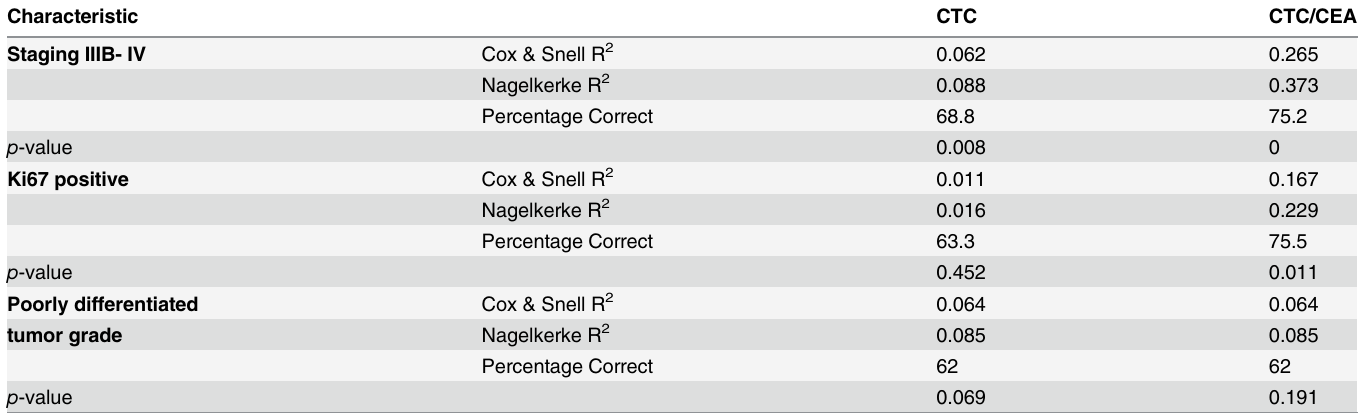
Table 6. Prediction of NSCLC aggressiveness and TNM staging with CTCs or/and